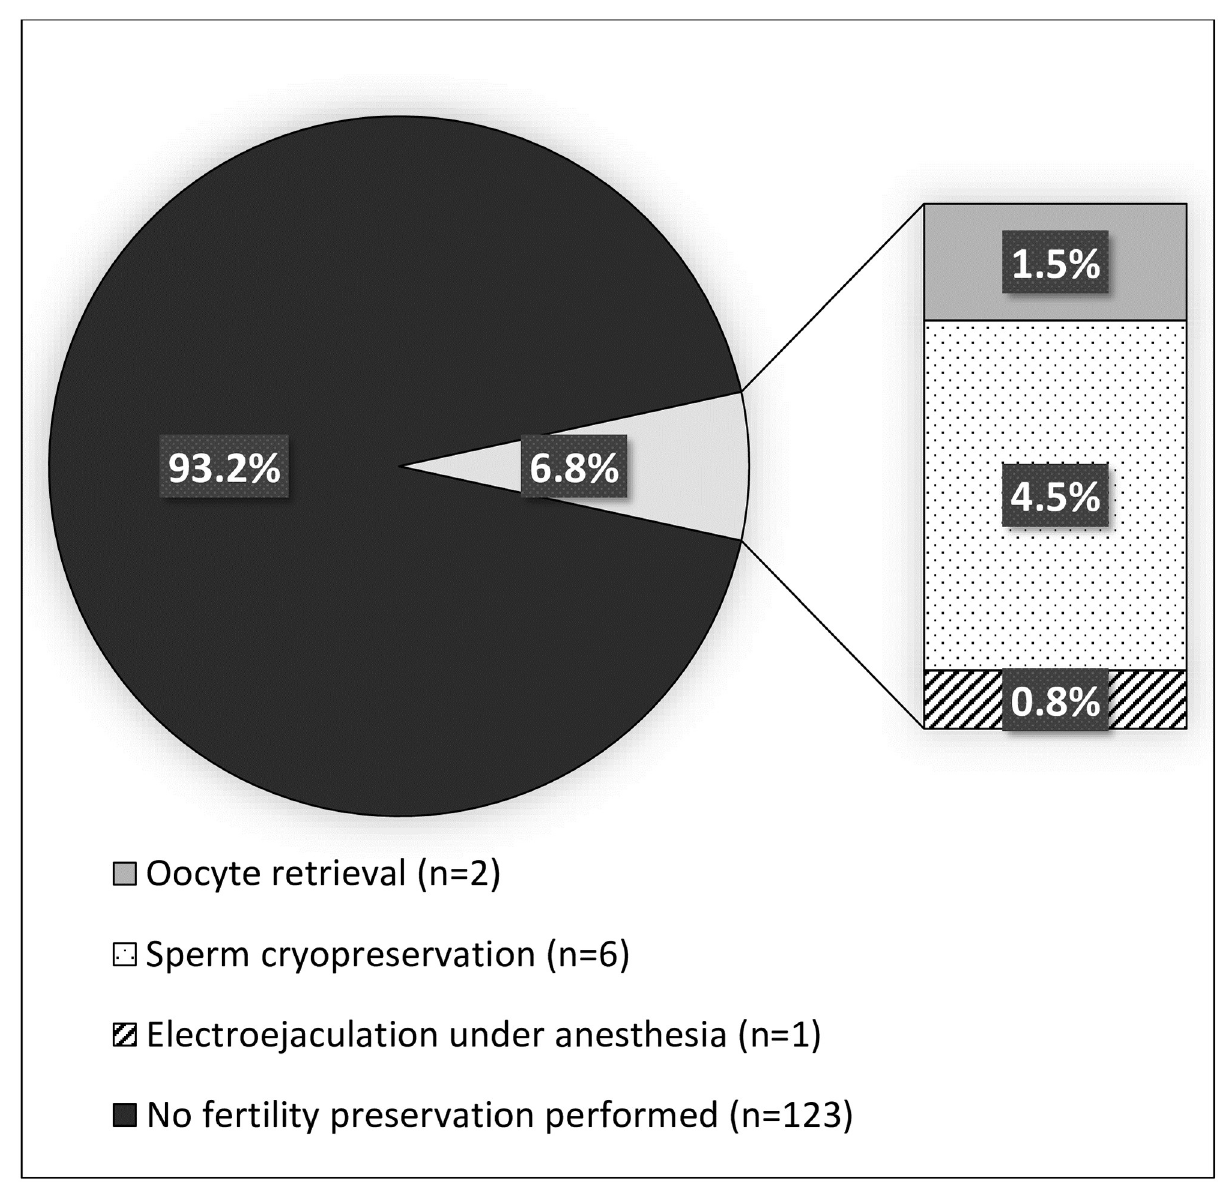
Fig 2. Overall fertility preservation rates. Fertility preservation rates in the Stanford Pediatric & Adolescent Gender Clinic from October 2015 through March 2019 (total n = 132).